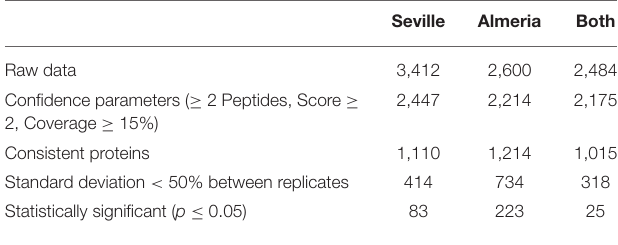
TABLE 2 | Summary of proteins identified by the shotgun–MS/MS analysis in the two populations and their combination.